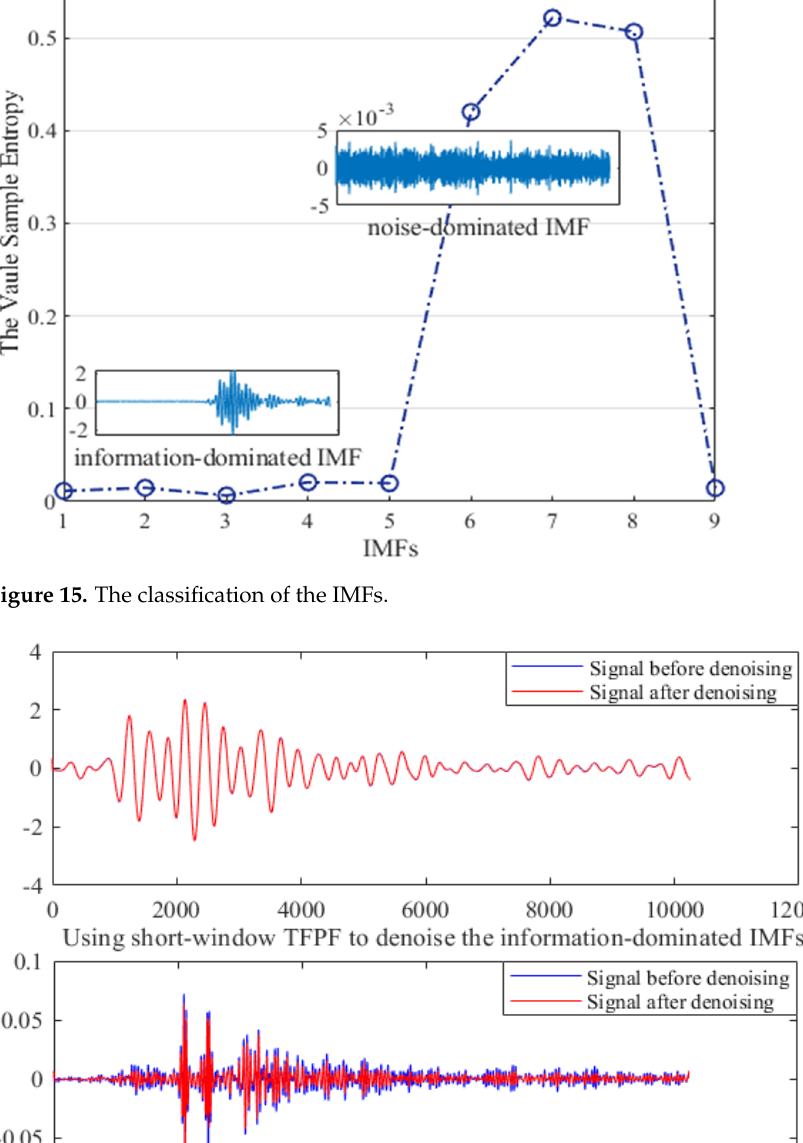
Figure 14. VMD decomposition of the output signal.